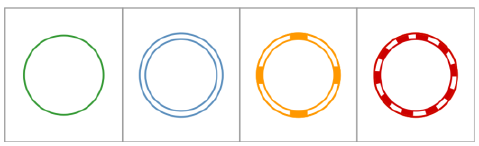
Figure 2. In Emergency Response Symbology a visual hierarchical status on the damage and operational level from Fully operational (left) to Totally incapacitated (right) can be additionally assigned to the symbols from the categories Operations and Infrastructure.